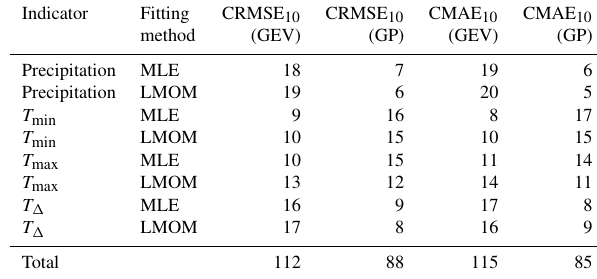
Table 3. Comparison of parameter estimation methods for the AMS approach based on conditional goodness-of-fit measures CRMSE 10 and CMAE 10 . Numbers indicate success cases of MLE and LMOM.